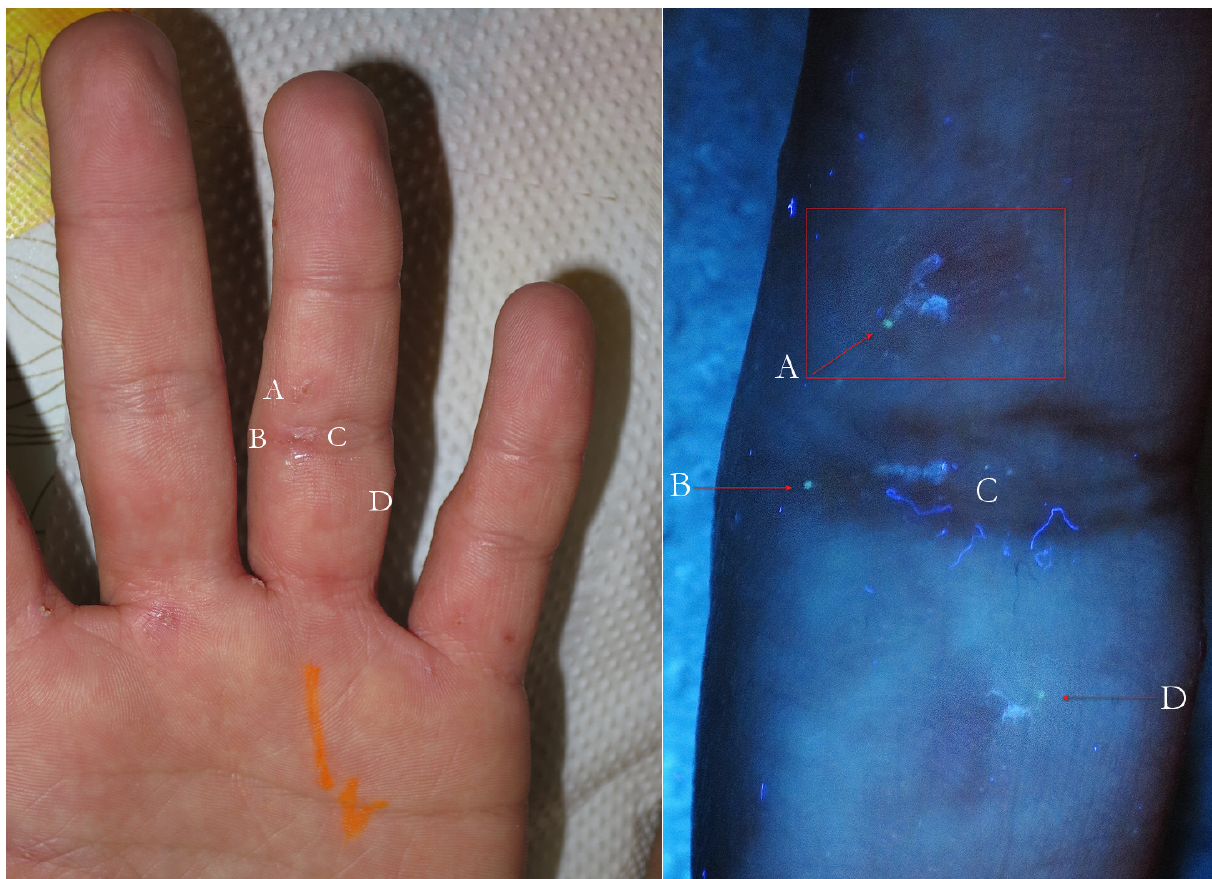
Figure 14. Flash light vs. UVA. On the left, some very suggestive signs of MGUs that in full ‐ frame view on the right corresponded to two green dots beside galleries (A–D), one isolated green dot (B) and a white line alone (C). B and C probably belonged to the same Mite ‐ Gallery Unit. Sharp blue tortuous lines are fabric threads on background. A red highlighter was used.